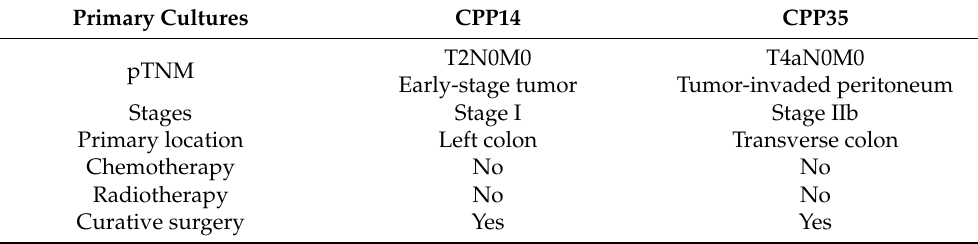
Table 1. Clinical data from colorectal cancer patients from whom primary cultures were established. Primary